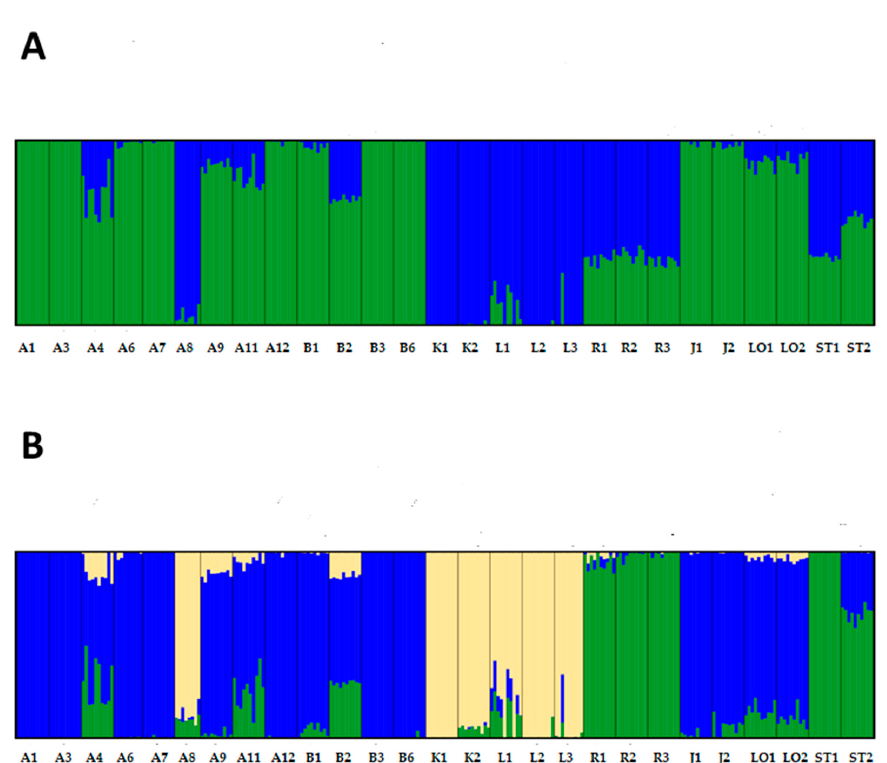
Figure 3. STRUCTURE analysis based on the full SNP dataset, assuming A two genetic clusters (K = 2); B three genetic clusters (K = 3). Different colours symbolize the different genetic clusters identified in each individual.